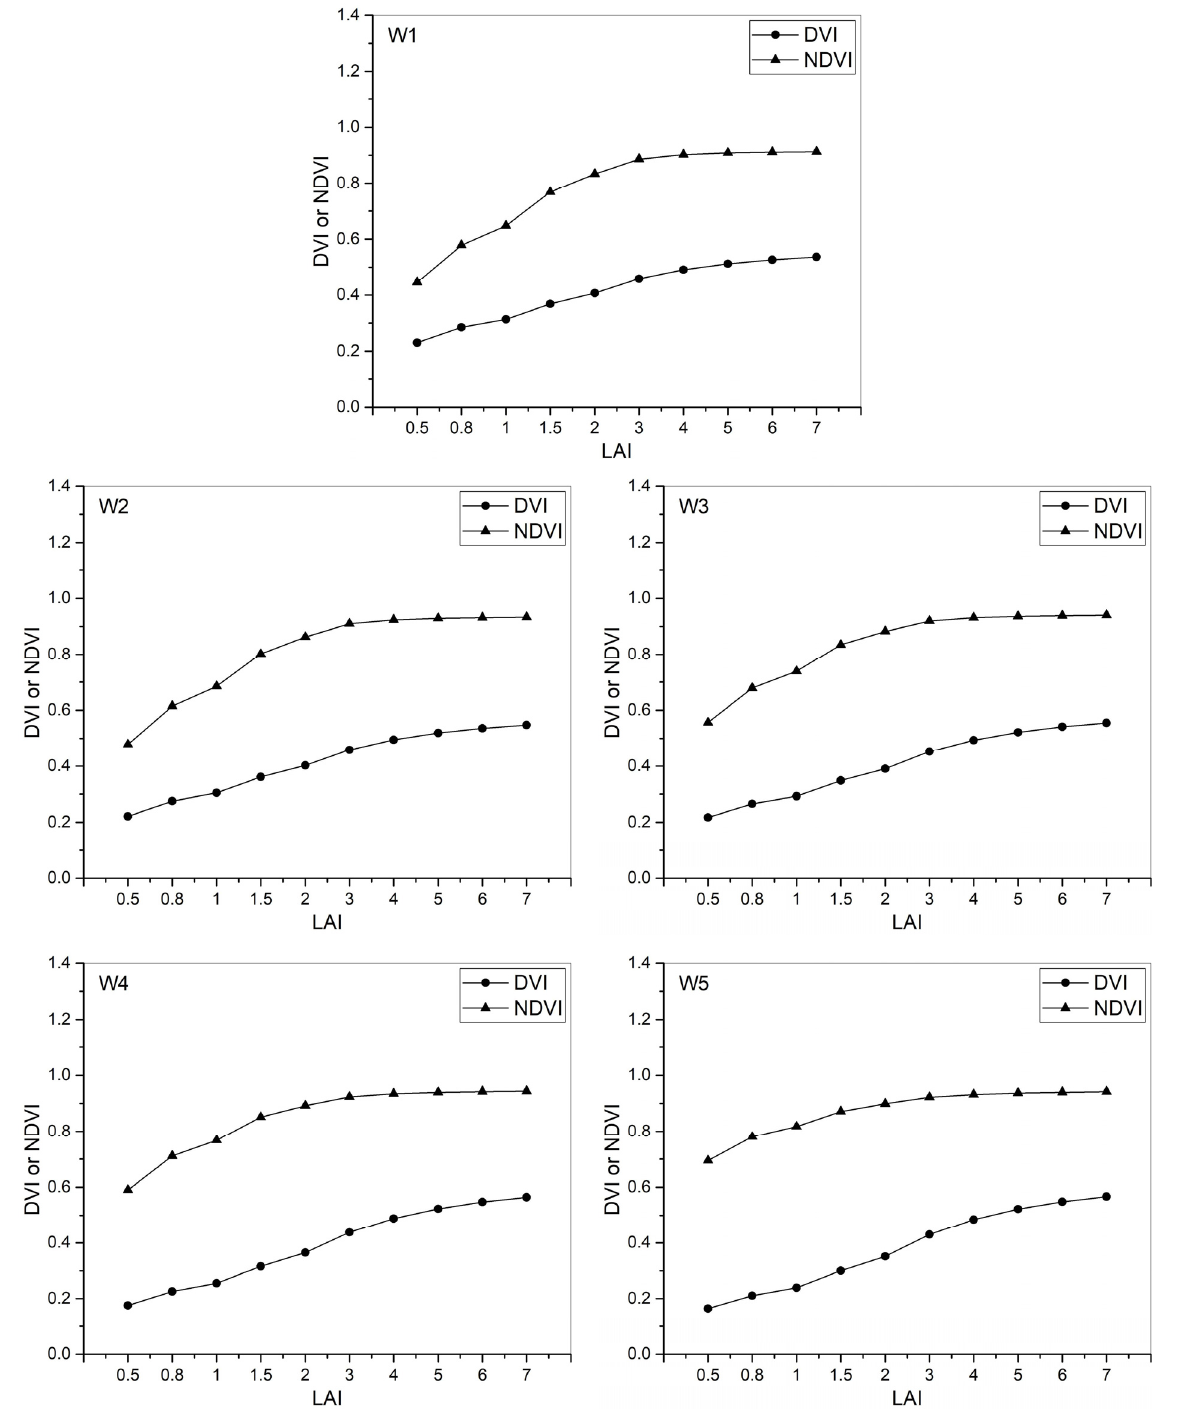
Figure 9. Effects of different LAI on vegetation index under continuous water